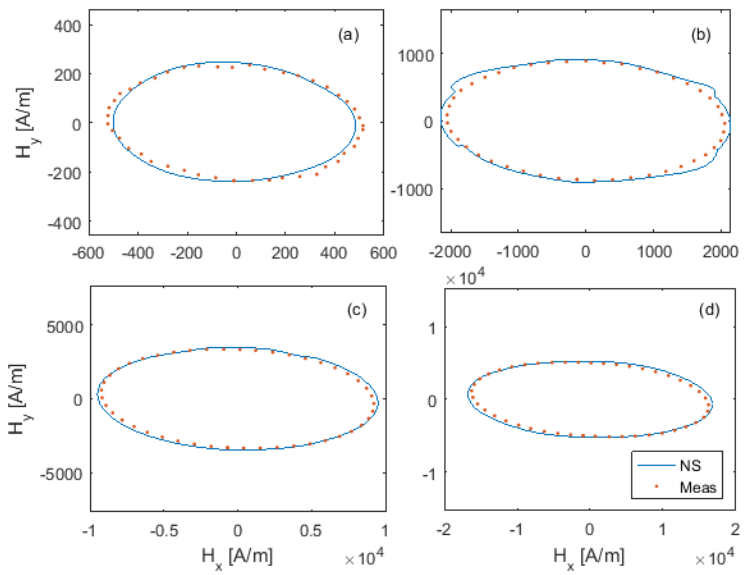
Figure 7. Comparison between simulated and measured trajectories of the H field relative to the